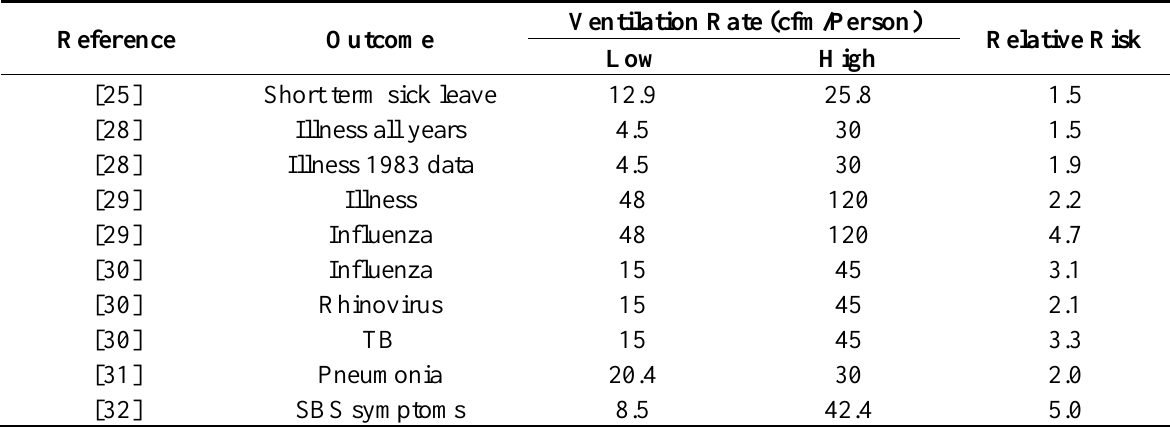
Table 5. Health impacts of ventilation rate in medium office prototype building (adapted from Fisk et al.